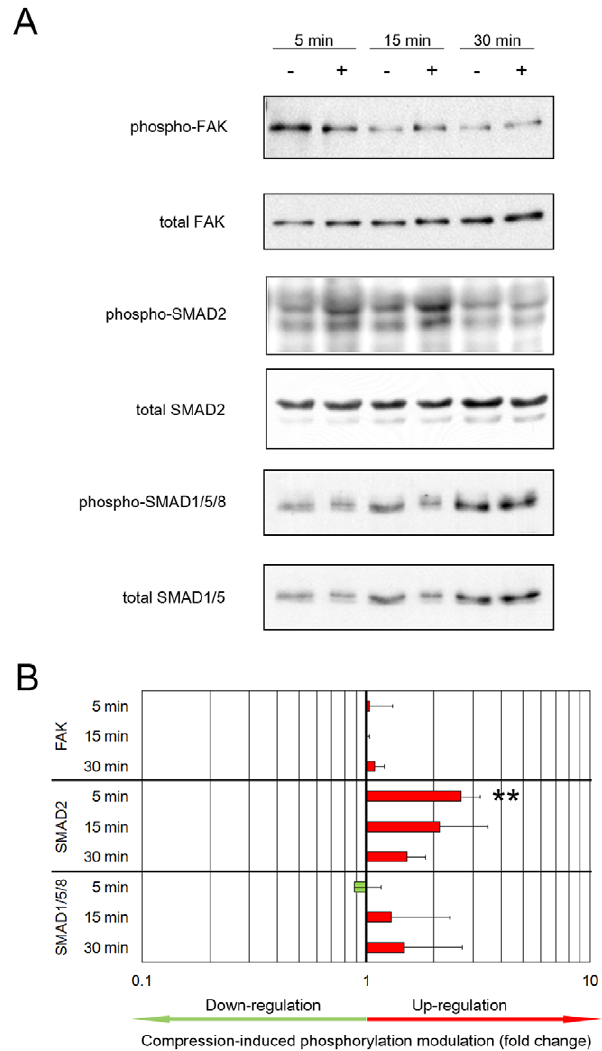
Figure 3. Smad2, but not Smad1/5/8 or FAK, is activated by compression in chondrocyte-agarose constructs. Chondrocytes cultured in agarose for 6 days underwent dynamic compression ( + ) or were not compressed ( 2 ) for the indicated times and the phosphor- ylation levels of FAK, Smad2 and Smad1/5/8 were analysed on Western blots. (A) Representative blots. (B) For FAK phosphorylation, densito- metric analysis was performed on three (5 and 15 min) or two (30 min) independent experiments. For SMAD phosphorylation, densitometric analysis was performed on four (5 and 15 min) or three (30 min) independent experiments. For each protein, the ratio of the phospho- protein to the total protein was calculated and the value obtained for mechanically-induced phosphorylation was normalised to uncom- pressed controls. Bars represent the compression-induced phosphory- lation modulation (mean + / 2 SD), with up-regulation in red and down- regulation in green (** p , 0.01).